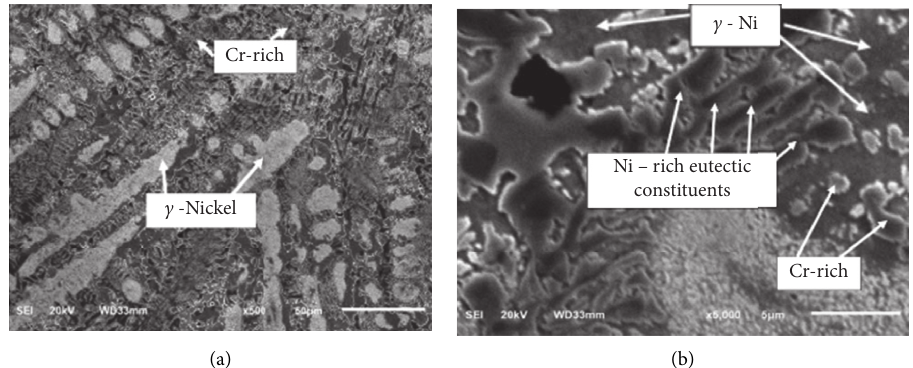
Figure 5: Scanning electron micrograph of laser hardfaced